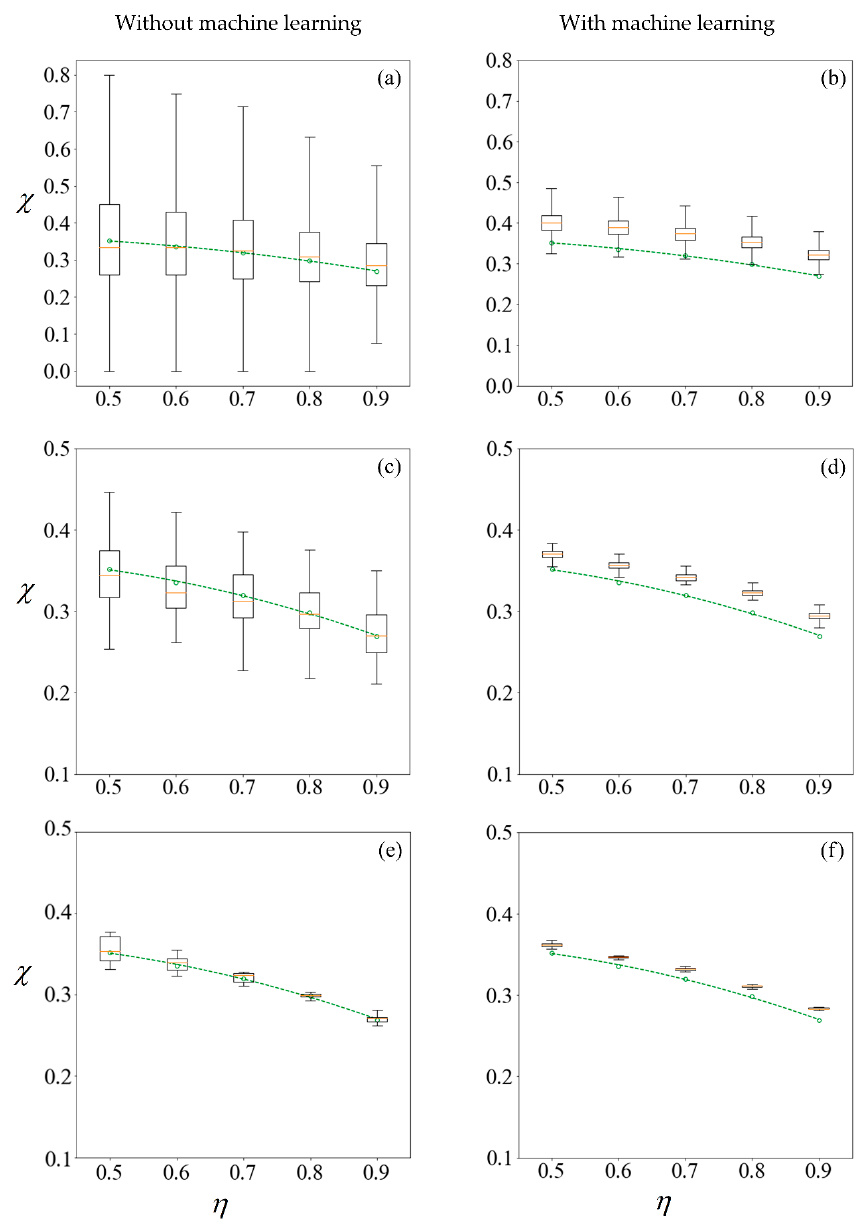
Figure 10. Boxplots representing results computed ( left column ) and predicted ( right column ) from training sets of size 100, 1000, and 10,000 samples in the first row ( a , b ); second row ( c , d ) and third row ( e , f ), respectively. The circle markers are results computed from 10 5 samples, while the dashed-line is the best fit polynomial. A C 0 value of − 1 mN/mm 3 is used for sorting. The machine learning model makes predictions on the remainder of the 100,000 samples less those used for training.